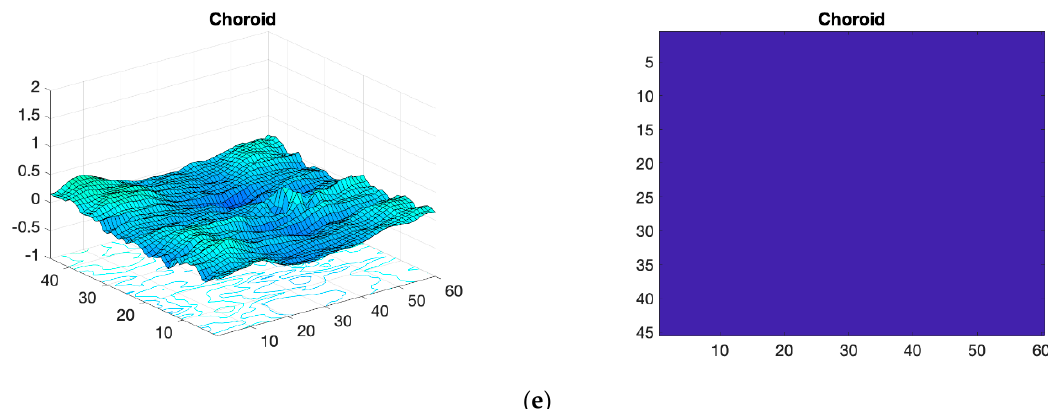
Figure 6. Processed OCT images of real subjects. Left: Cohen’s d value for the various structures. Right: the best regions, selected with a threshold of d TH = 1.02 (identical for all layers), are shown in yellow. ( a ) Complete retina; ( b ) RNFL; ( c ) GCL+; ( d ) GCL++; ( e ) choroid.